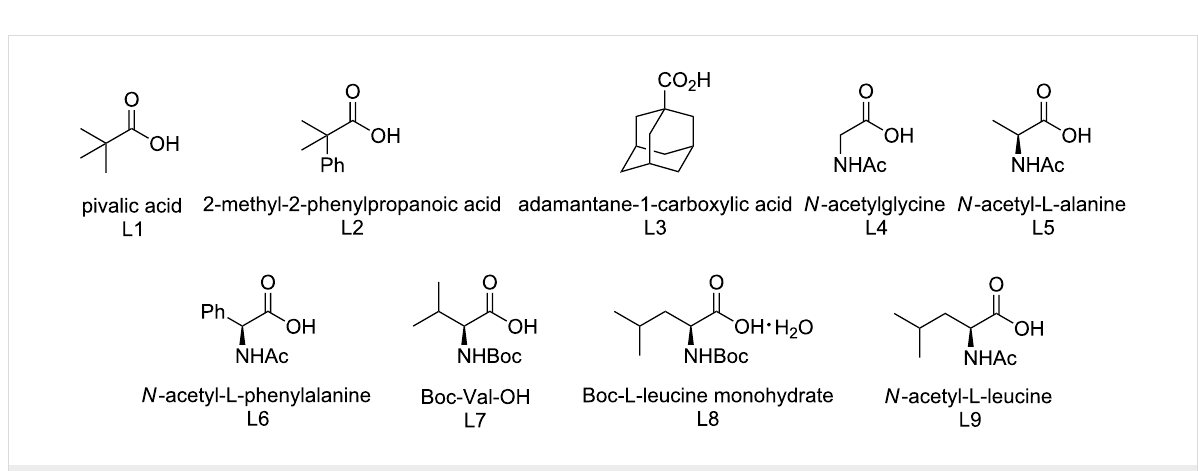
Scheme 3: A variety of organic acids and monoprotected amino acids as